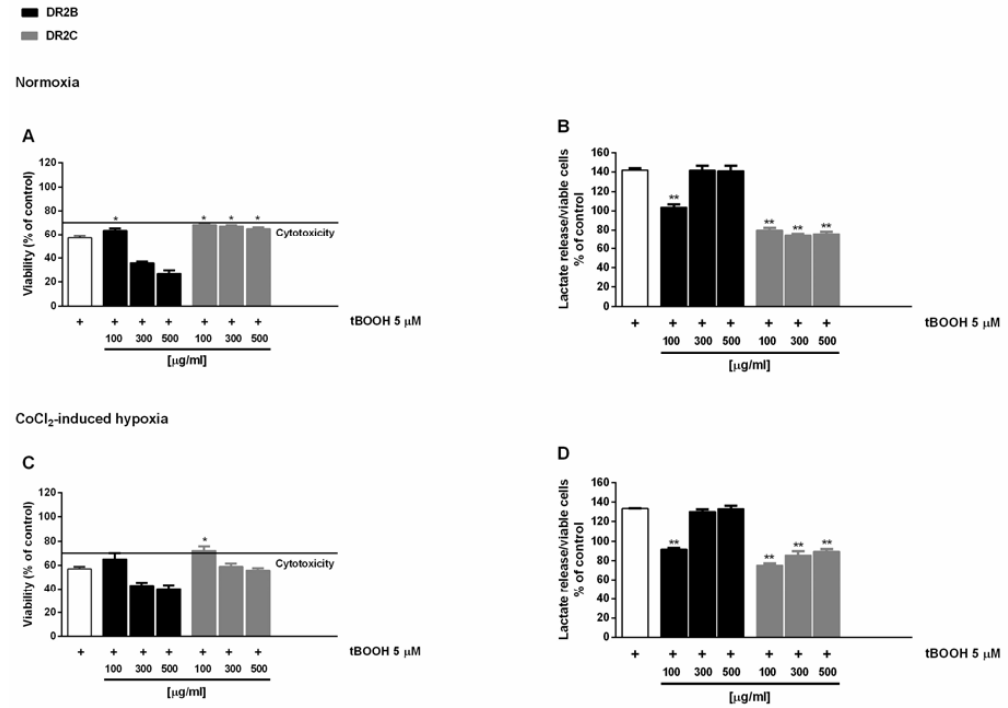
Figure 1. Effect of DR2B and DR2C extracts (100–500 μ g/mL) on the oxidative damage induced